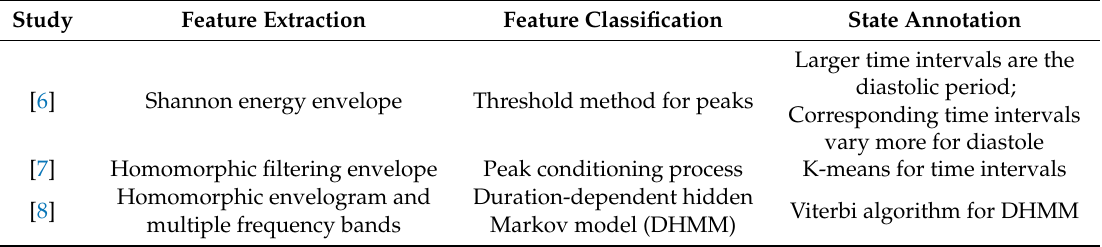
Table 1. Brief summaries of some heart sound segmentation